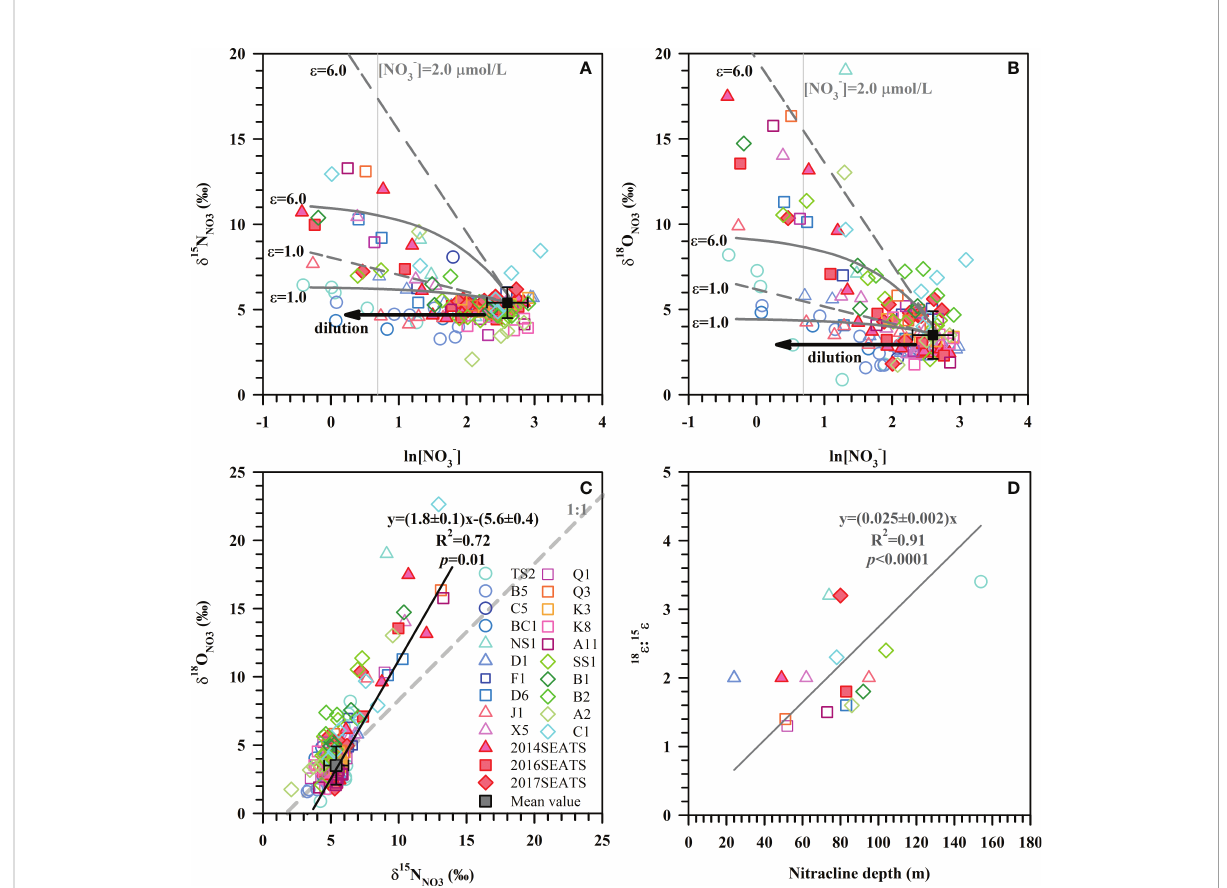
FIGURE 2 Values of d 15 N NO3 (A) and d 18 O NO3 (B) versus the natural logarithm of [NO 3 – ] for all stations. These data overlay models of NO 3 – uptake based on the average NO 3 – concentration and isotope at a depth of 200 m (black square, [NO 3 – ]=14.8 ± 4.0 m mol/L, d 15 N NO3 = 5.4 ± 0.9 ‰ , d 18 O NO3 = 3.5 ± 1.4 ‰ , n=23). The straight dashed lines represent the Rayleigh model while the concave-down lines represent the Open system model. The black arrows represent the dilution effect of Kuroshio intrusion with low concentrations of NO 3 – . The gray vertical lines denote the nitracline of 2.0 m mol/L. (C) The relationship between 18 ϵ : 15 ϵ ratios and the nitracline depth. (D) Scatter plot of d 18 O NO3 versus d 15 N NO3 for all stations. The solid line is the best fi tting curve for all datapoints. The gray dashed line represents a 1:1 NO 3 – isotope assimilation